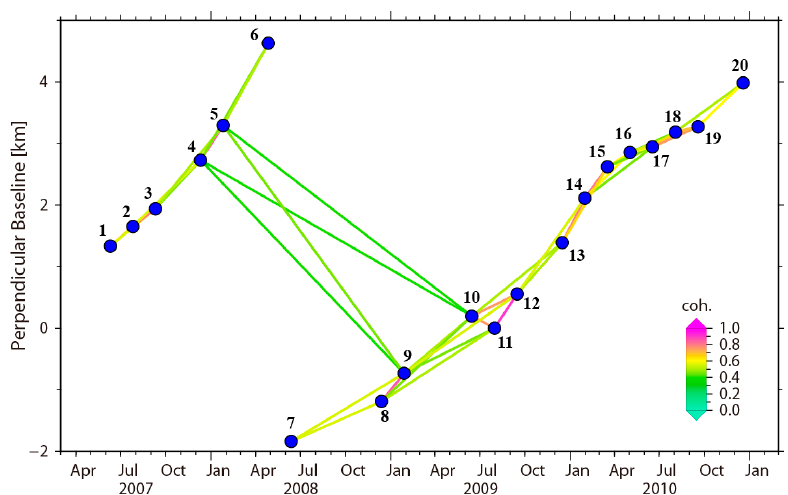
Figure 4. The network of the selected interferometric pairs. Blue dots denote a SAR image acquisition. Lines between blue dots are interferometric pairs, the colors of which represent the average coherence (coh.) of the corresponding